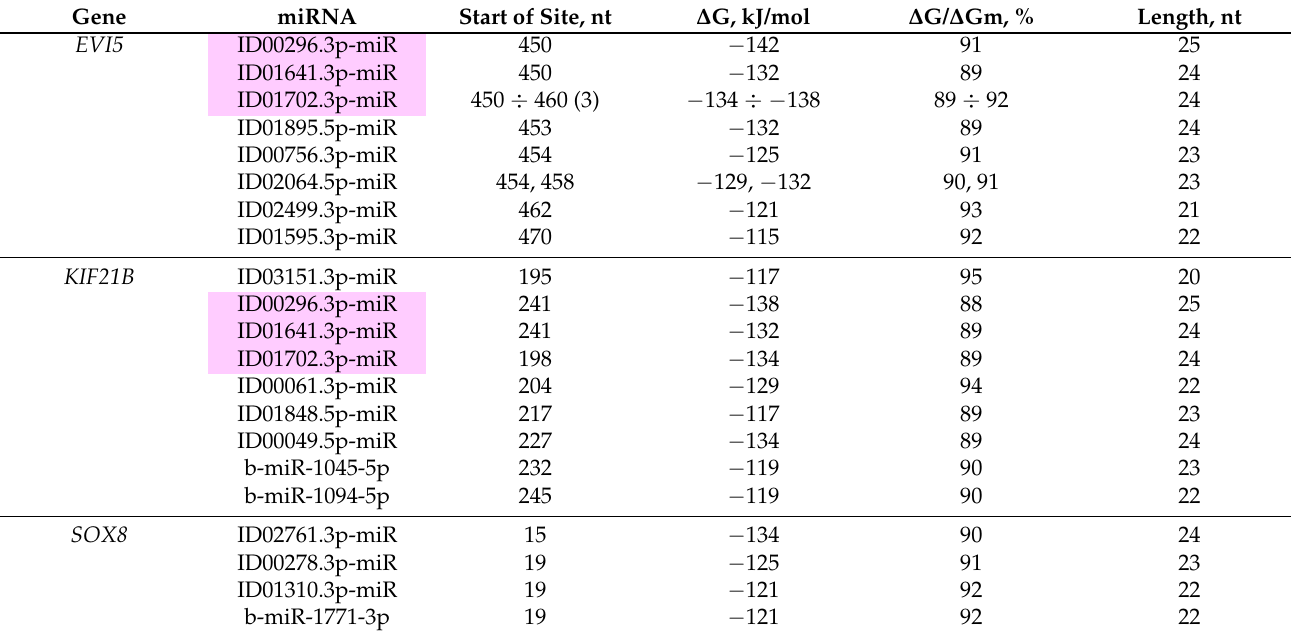
Table 1. Characteristics of miRNA interactions with 5 (cid:48) UTR mRNA of MS candidate